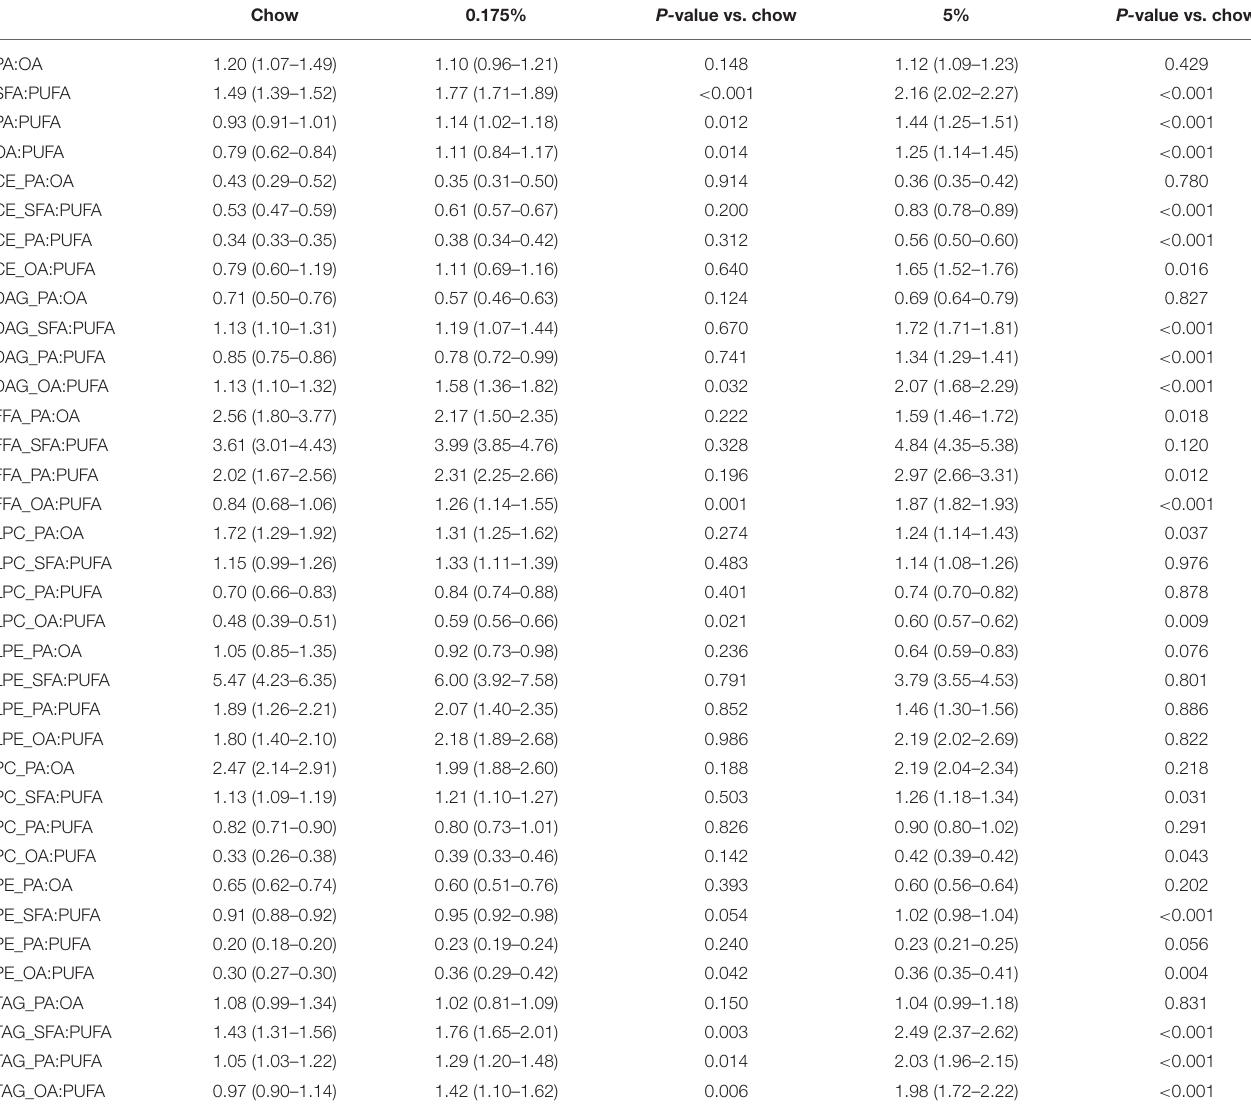
TABLE 4 | Effect of 0.175% lard and 5% lard diets on PA to OA, SFA to PUFA, PA to PUFA and OA to PUFA ratios in total lipids and lipid classes. Chow 0.175% P- value vs. chow 5% P- value vs.